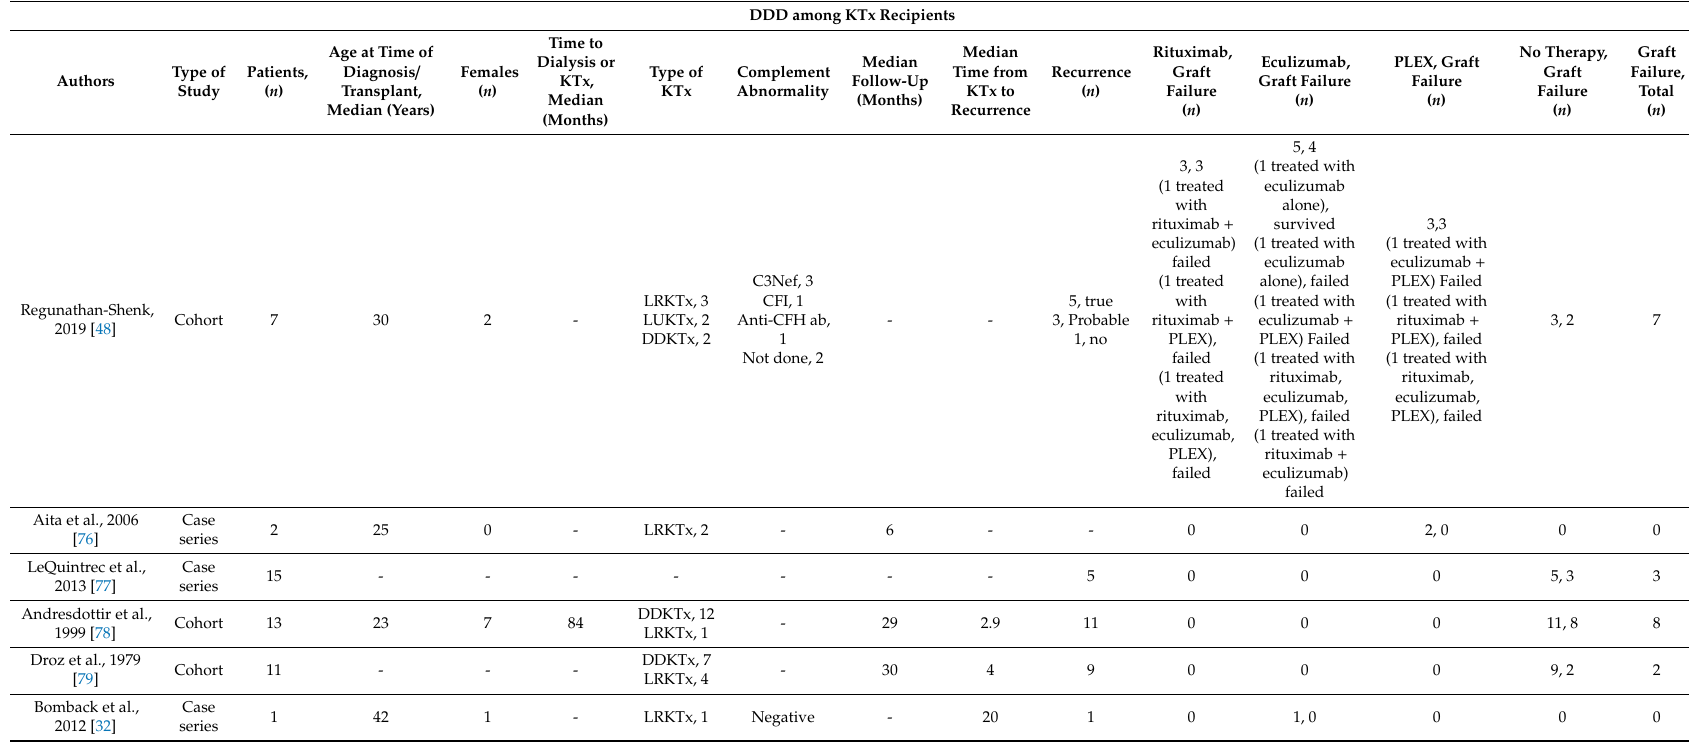
Table 2. Characteristics of the included studies in this systematic review of outcomes of KTx patients with